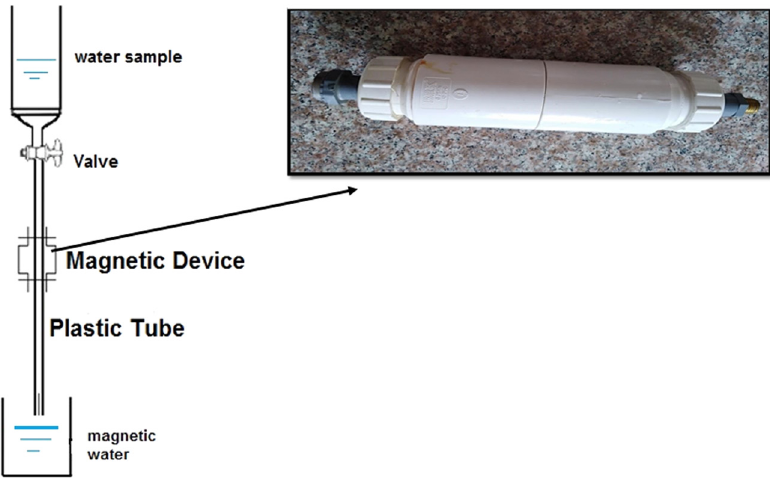
Figure 2: Schematic diagram of the experiment.